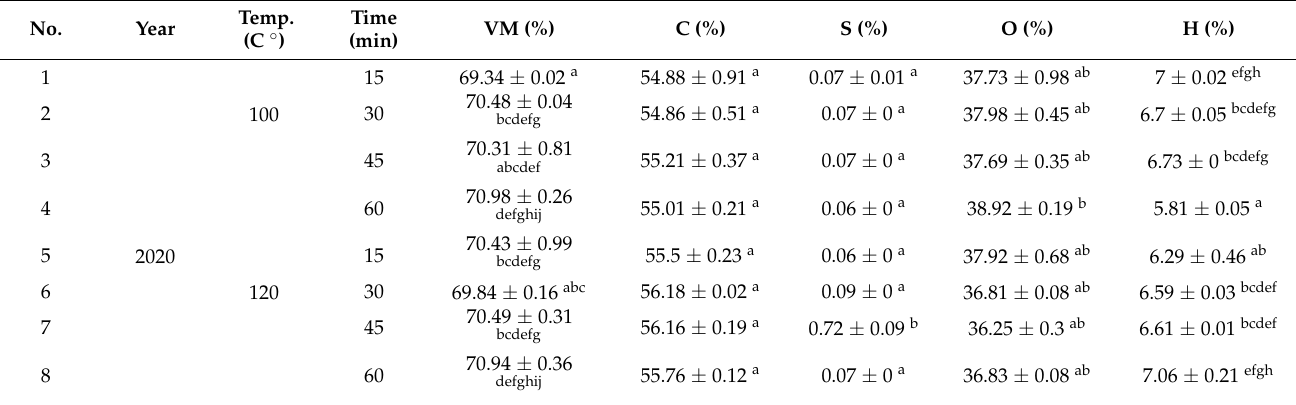
Table 3. Content of combustible substances in hazelnut shell after conductive drying